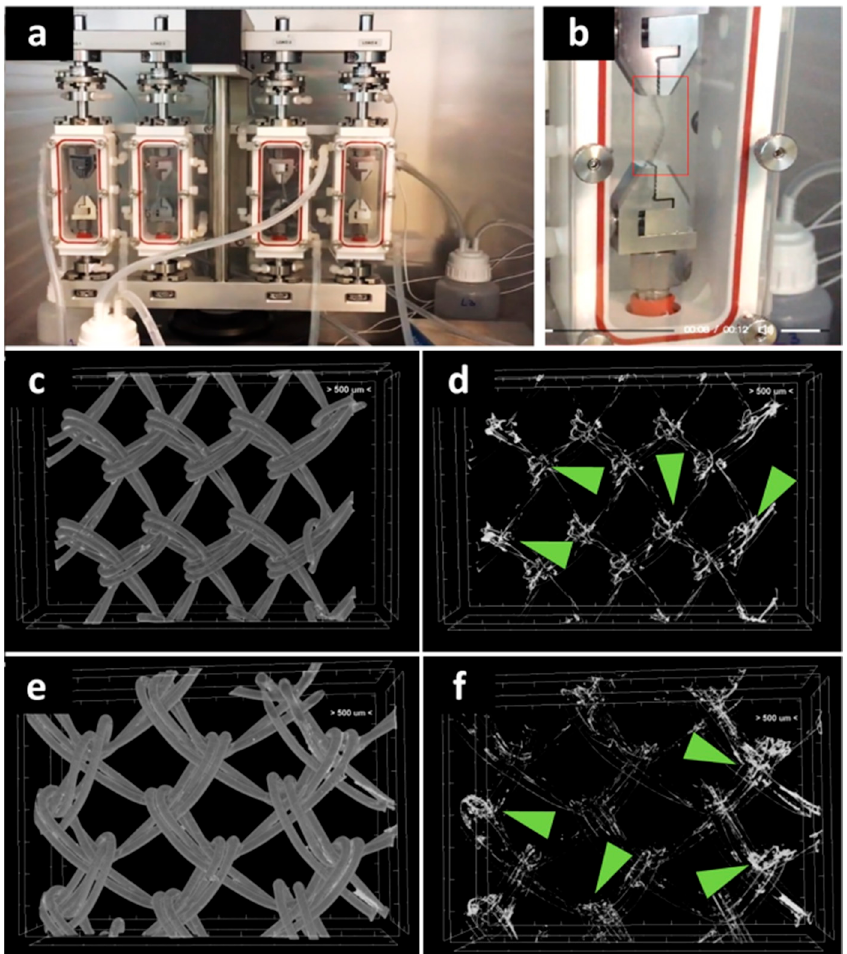
Figure 2. Investigation of protein coating stability at seven days through biodynamic testing: digital photographs of meshes during testing ( a , b ). Micro-CT images of the protein-coated PP meshes after seven days biodynamic test: ( c ) PPG; ( d ) GelMA coating after isolation of the natural-derived coating from the PP mesh; ( e ) PPM; ( f ) MuMA coating isolated from the PP mesh; green arrows indicate silver (staining the hydrogel) richer areas at the mesh knots.